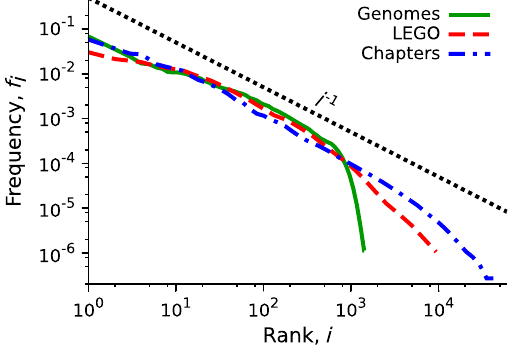
FIG. 2. Different empirical component systems show similar component frequency distributions. The rank plot of the compo- nent frequencies is reported for the three data sets (book chapters, genomes, LEGO sets). The frequency of a component is defined as the abundance of that component in the whole data set normalized by the total number of components (Fig. 1). The three curves follow similar behavior, which can be described qualitatively as a power-law-like decay with exponent close to 1 for low ranks (high frequency), and a faster data-set-specific decay for higher ranks.